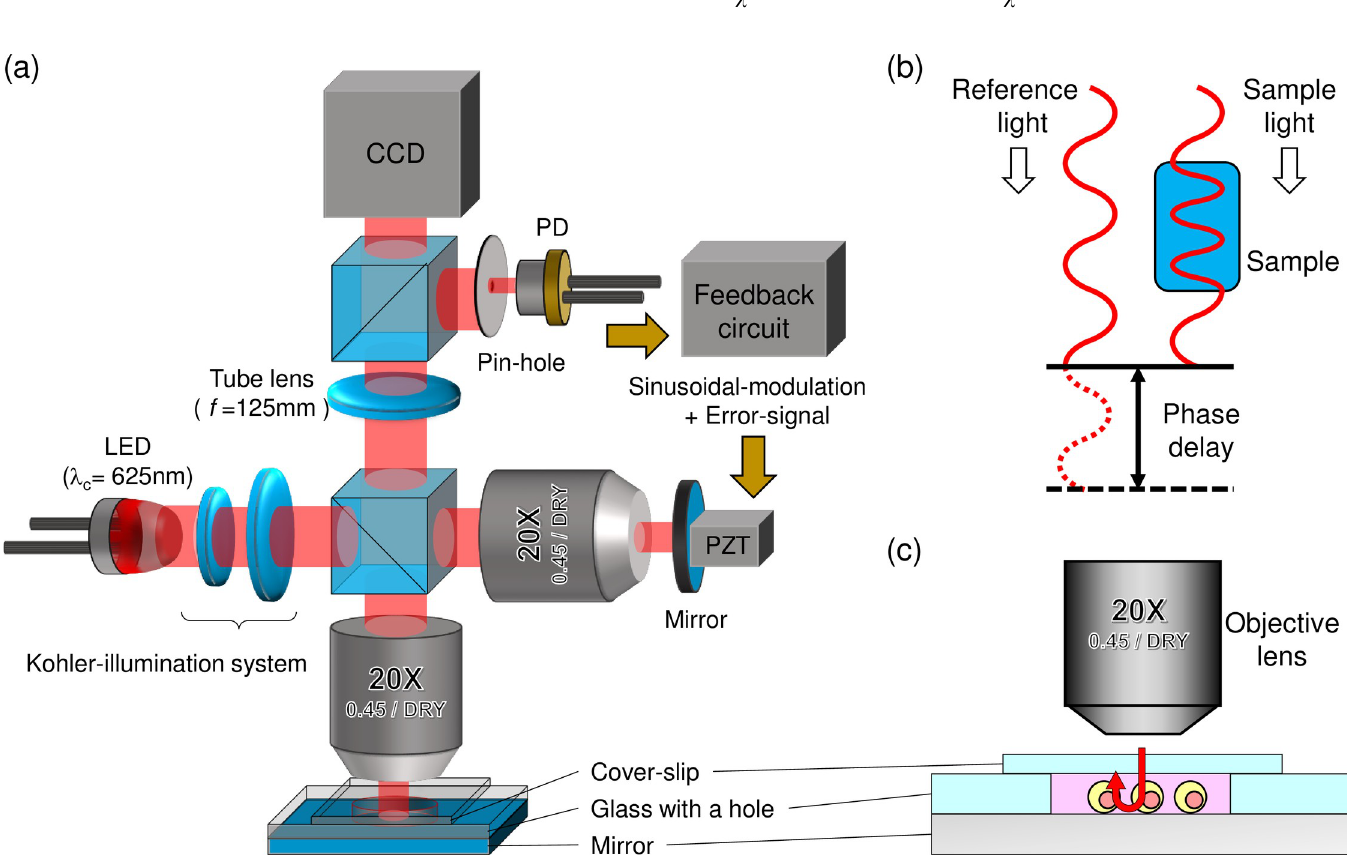
Fig 1. Schematic of imaging system and principle of phase measurement. (a) Schematic of reflection-type quantitative phase microscope. (b) Principle of phase measurement of the sample in QPM. (c) Configuration of custom-made slide chamber for cells in reflection-type QPM.